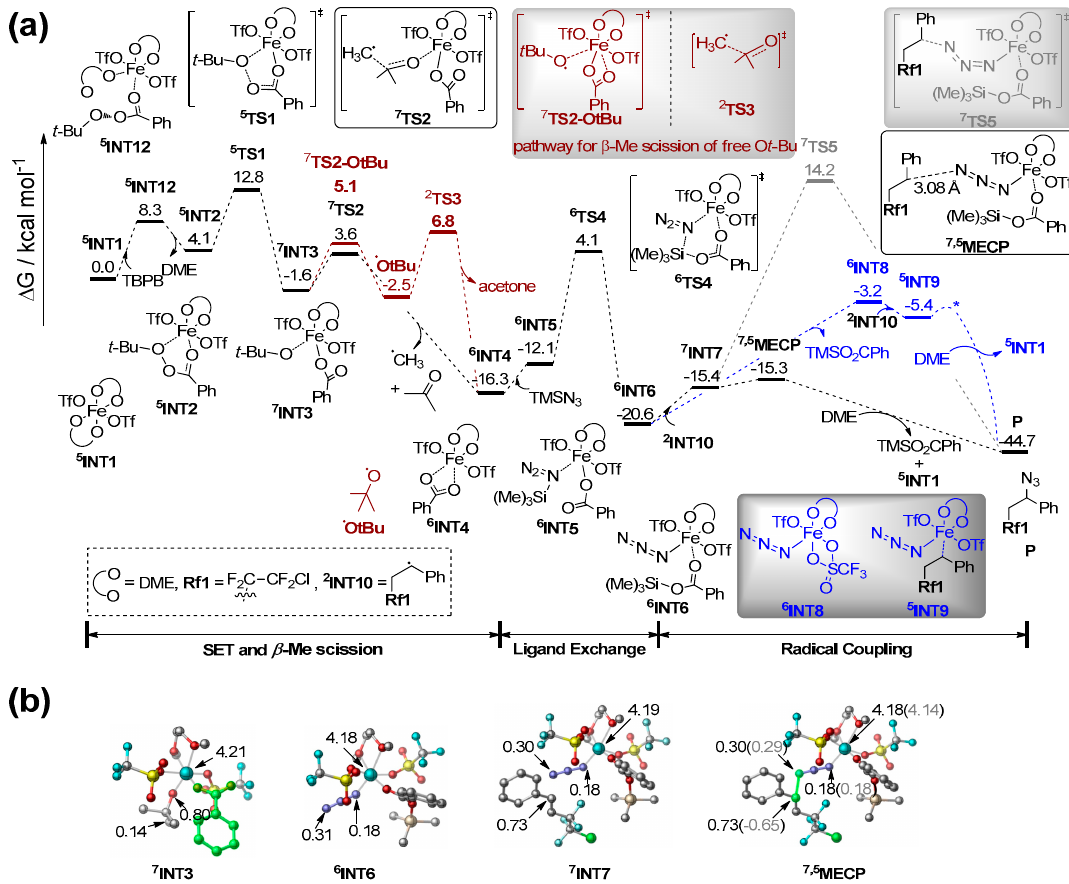
Figure 1. ( a ) The Gibbs free energy profile of the Fe-catalyzed carboazidation of alkenes. The transition state corresponding to reductive elimination from 5 INT9 cannot be explicitly located and is indicated as *. ( b ) Optimized structures of selected intermediates. Spin densities on selected atoms are shown in each structure beside the arrows. For 7,5 MECP , the spin densities of the quintet state are shown in parenthesis. Hydrogen atoms are omitted for clarity.